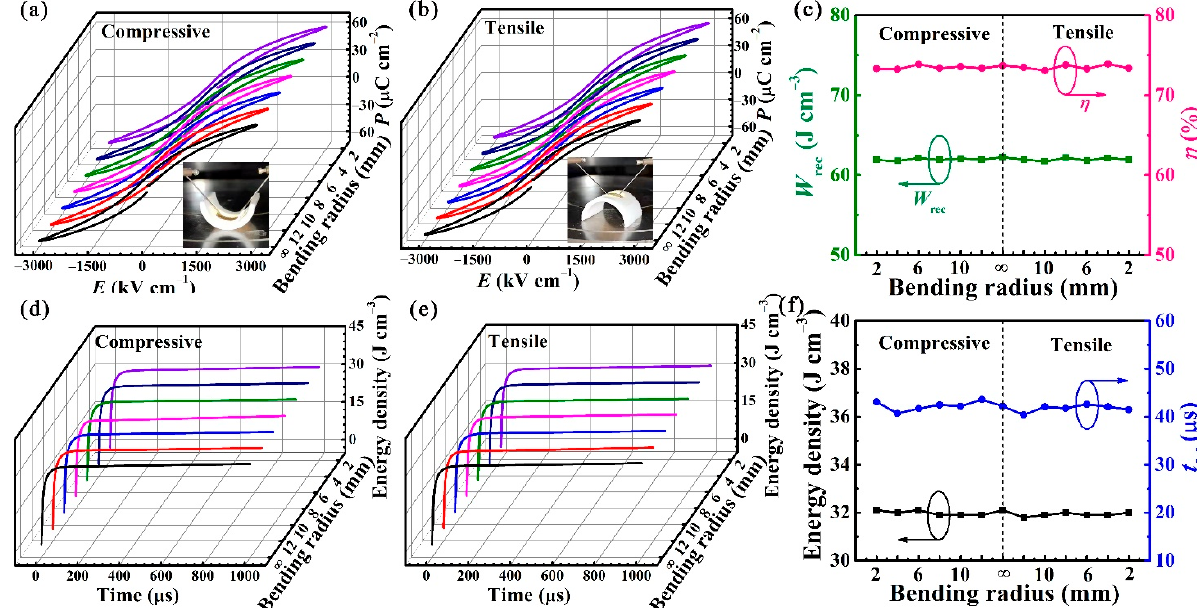
Figure 4. P - E loops measured at various ( a ) compressive radii and ( b ) tensile radii. The inset is the photographs of the BST/0.4BFO-0.6STO film under different bending states. ( c ) W rec and η as functions of the bending radius. The energy discharge behaviors at various ( d ) compressive radii and ( e ) tensile radii. ( f ) Discharged energy density and discharge speed as functions of bending radius. (The lines in Figure 4a,b,d,e from black to purple represent the measurements of the bending radius of BST/0.4BFO-0.6STO film from ∞ to 2 mm, respectively.)